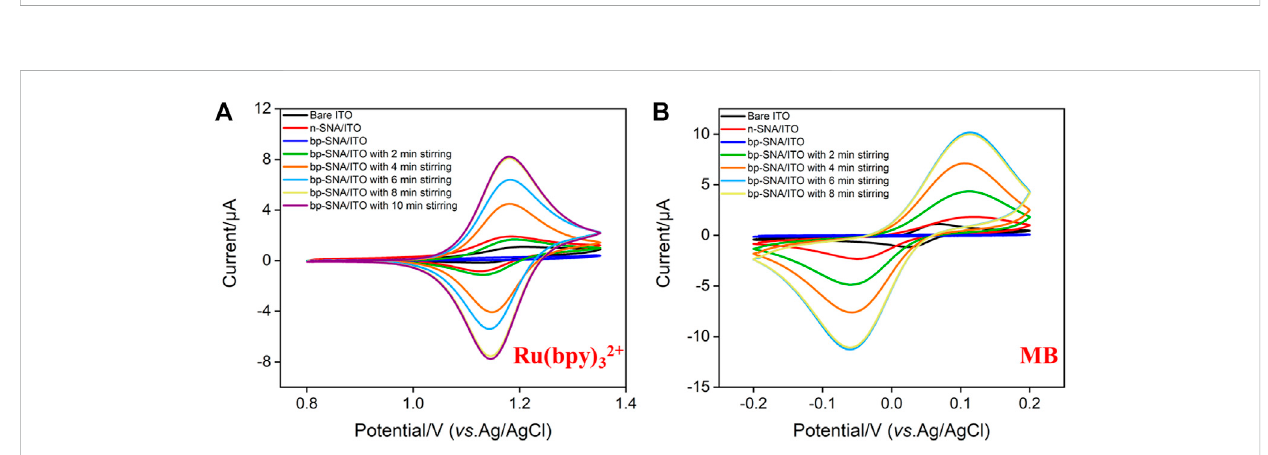
FIGURE 3 CV curves obtained on bare ITO, n-SNA/ITO, bp-SNA/ITO electrodes in KHP (0.05 M, pH = 4) containing 10 μ M Ru(bpy) 3 2+ (A) or MB (B) solution.